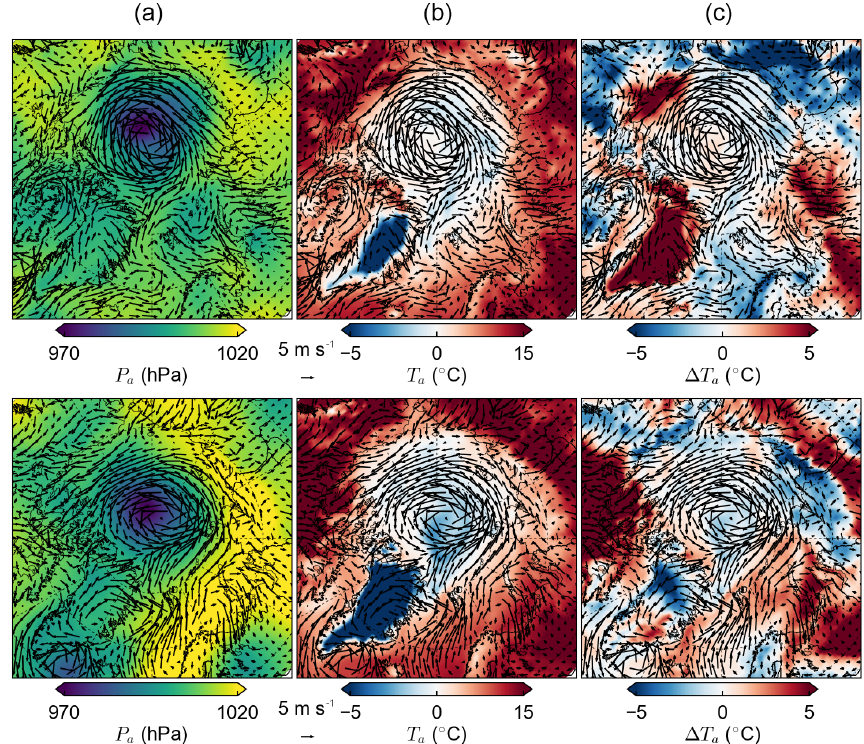
Figure 11. Sea level pressure (a) , near-surface air temperature (b) and near-surface air temperature anomaly relative to the 2000–2016 mean (c) for the peak summer Arctic storm time periods in 2012 (top, 6 August) and 2016 (bottom, 16 August) from NASA’s MERRA-2 reanalysis. The black vectors show the 10m